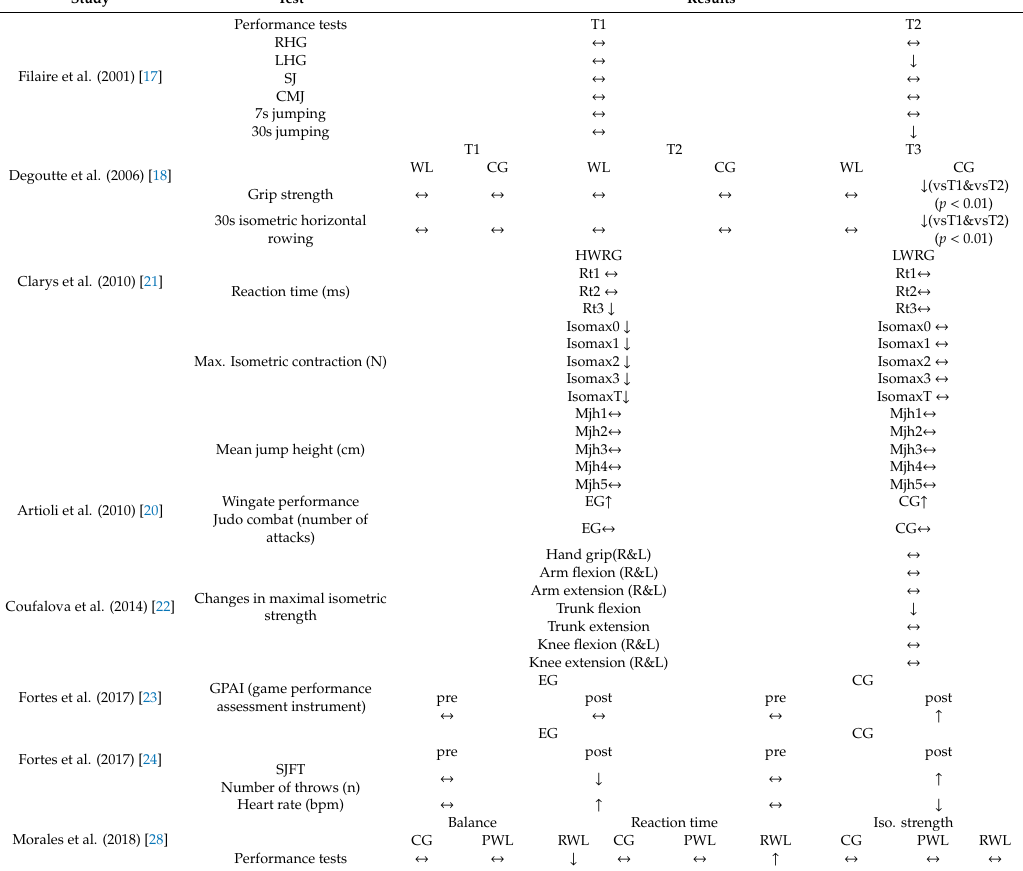
Table 2. E ff ects of rapid weight loss on physiological parameters in